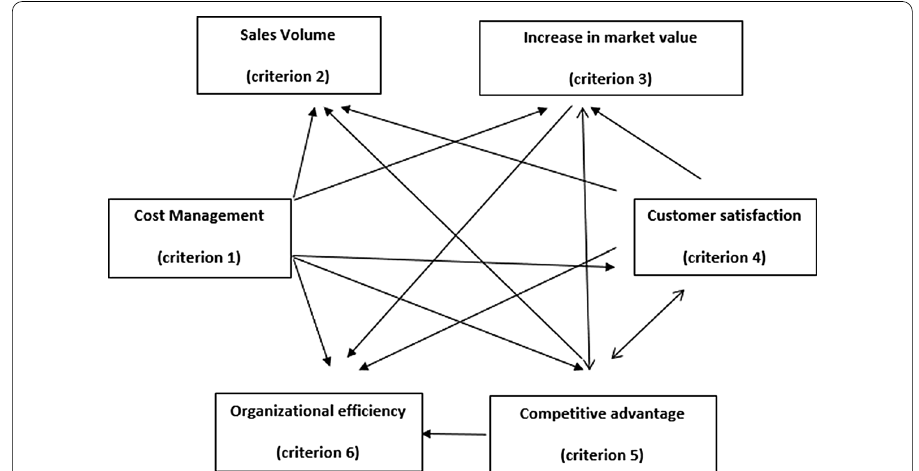
Fig. 3 Impact and relation map of fintech-based determinants. Source : Created by the